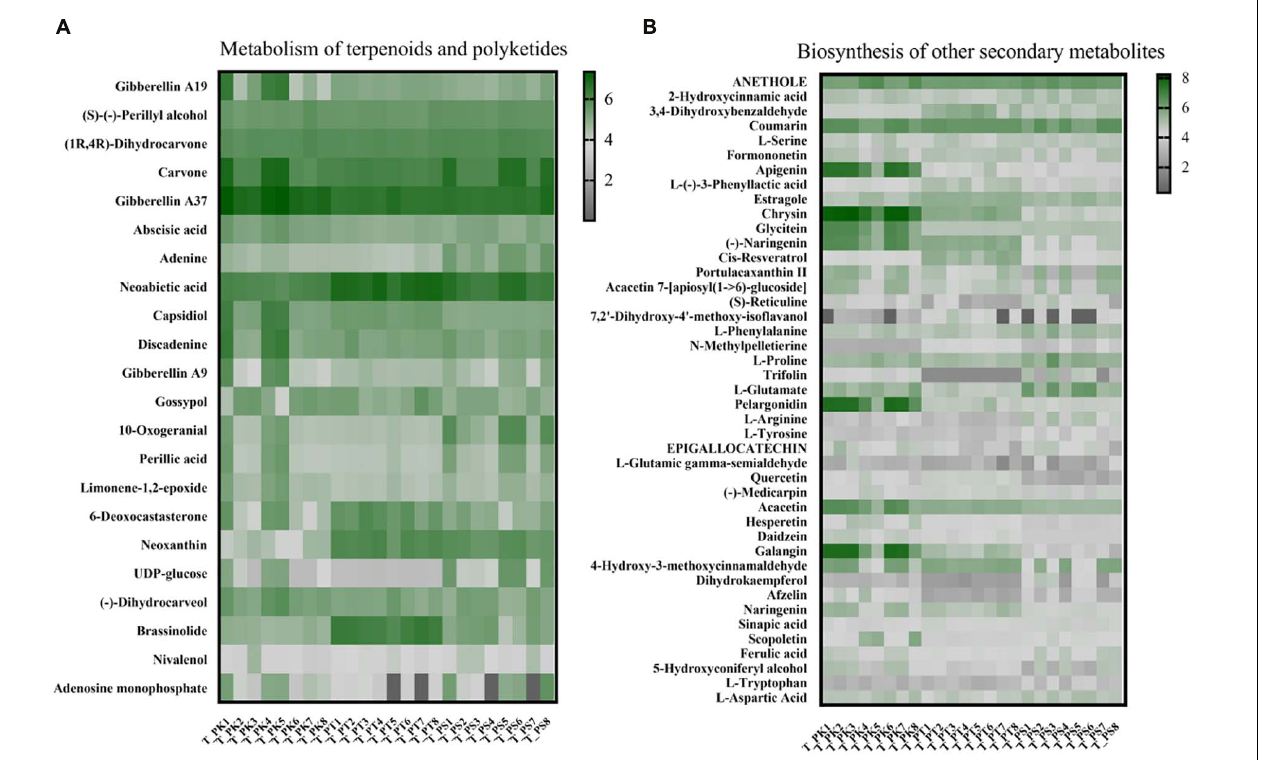
FIGURE 6 | Comparison of relative metabolite abundance in wood tissue from different host tree species. (A) Heat map of metabolites annotated in the pathway “metabolism of terpenoids and polyketides.” (B) Heat map of metabolites annotated in the pathway “biosynthesis of other secondary metabolites.” Each column corresponds to a host tree wood tissue sample, and each row corresponds to a specific metabolite. T_PK, xylem tissue from P. koraiensis ; T_PT, xylem tissue from P. tabuliformis ; T_PS, xylem tissue from P. sylvestris var. mongolica. All of these abbreviations apply to the following figures.